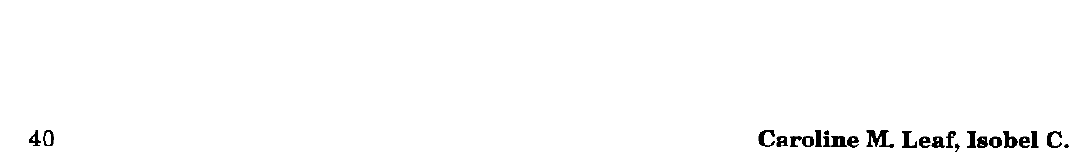
PREPARATION Breathing Relaxation